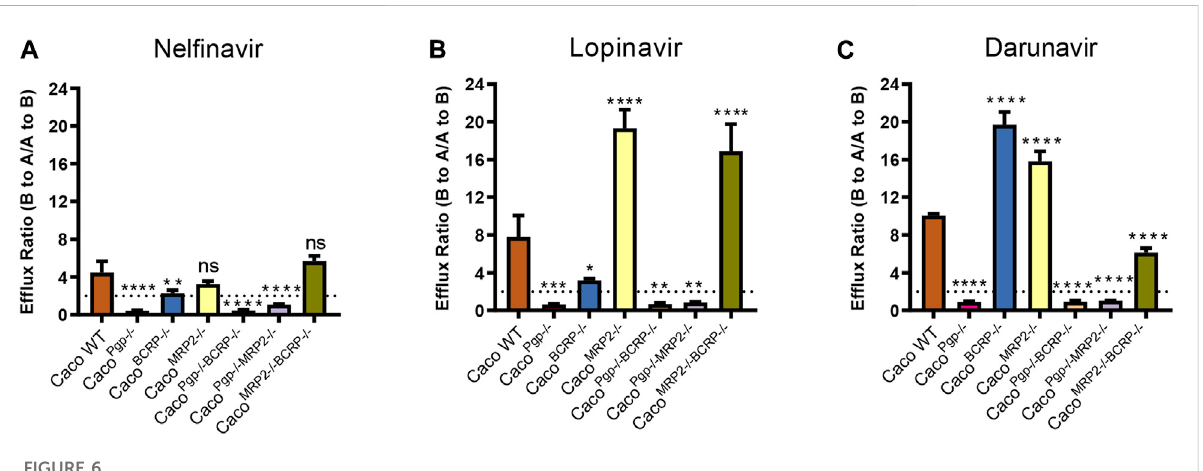
FIGURE 6 Ef fl ux ratios for 5 μ M nel fi navir (A) , 5 μ M lopinavir (B) and 5 μ M darunavir (C) in WT and KO cell lines. Data represents the mean ± SD; n = 3. The dotted line indicates the ER = 2. ns: not signi fi cant; * p < 0.05, ** p < 0.01, *** p < 0.001, **** p < 0.0001.